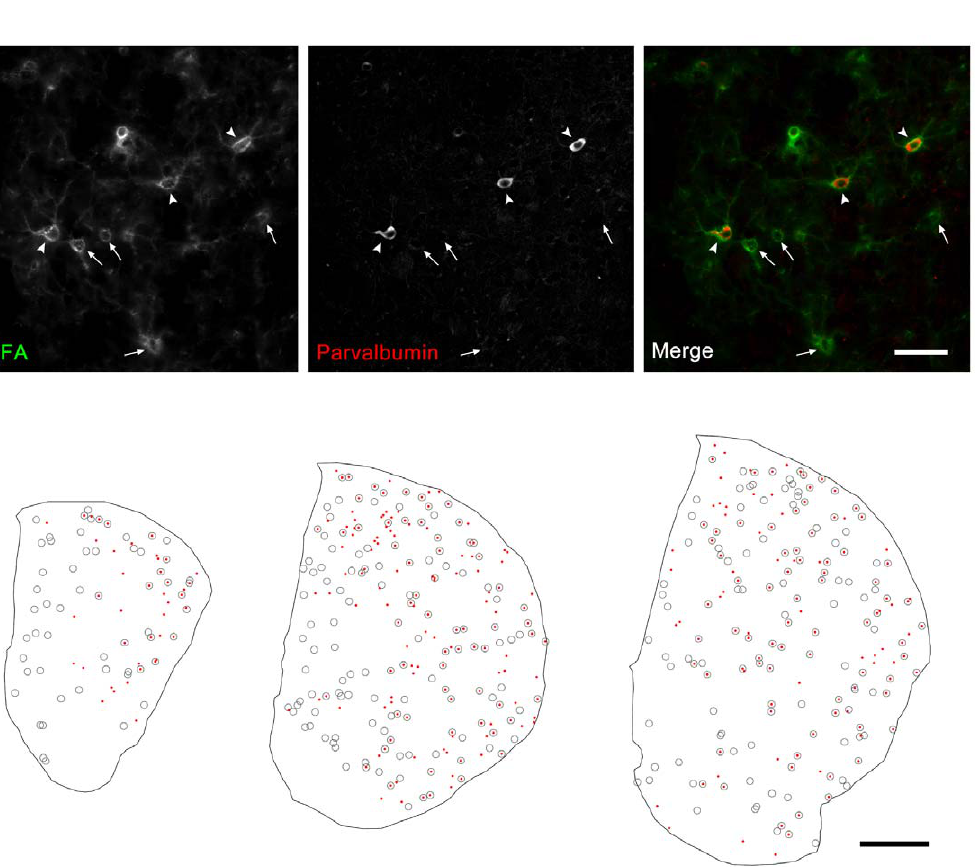
Figure 1. PNNs show considerable, but not exclusive overlap with PV + cells in the striatum. (A) Panels show high power micrographs revealing WFA/PNN labeling (left), PV + immuno-staining (middle), and a merged image of the two (right). Although WFA/PNN and PV + signals overlapped considerably (arrowheads), both PNNs without PV + co-labeling (arrows), as well as PV + cells without PNNs (not visible in this section) were also present. Scale bar: 100 m m. (B) Sample reconstructions of three coronal sections from the anterior striatum (Left to right: rostral, middle, and caudal) showing locations of PV + cell bodies (red dots) and PNNs (grey rings). Both the degree as well as localization of PNN/PV + overlap can be seen to vary across the rostro-caudal axis. Right: lateral, up: dorsal. Scale: 500 m m.